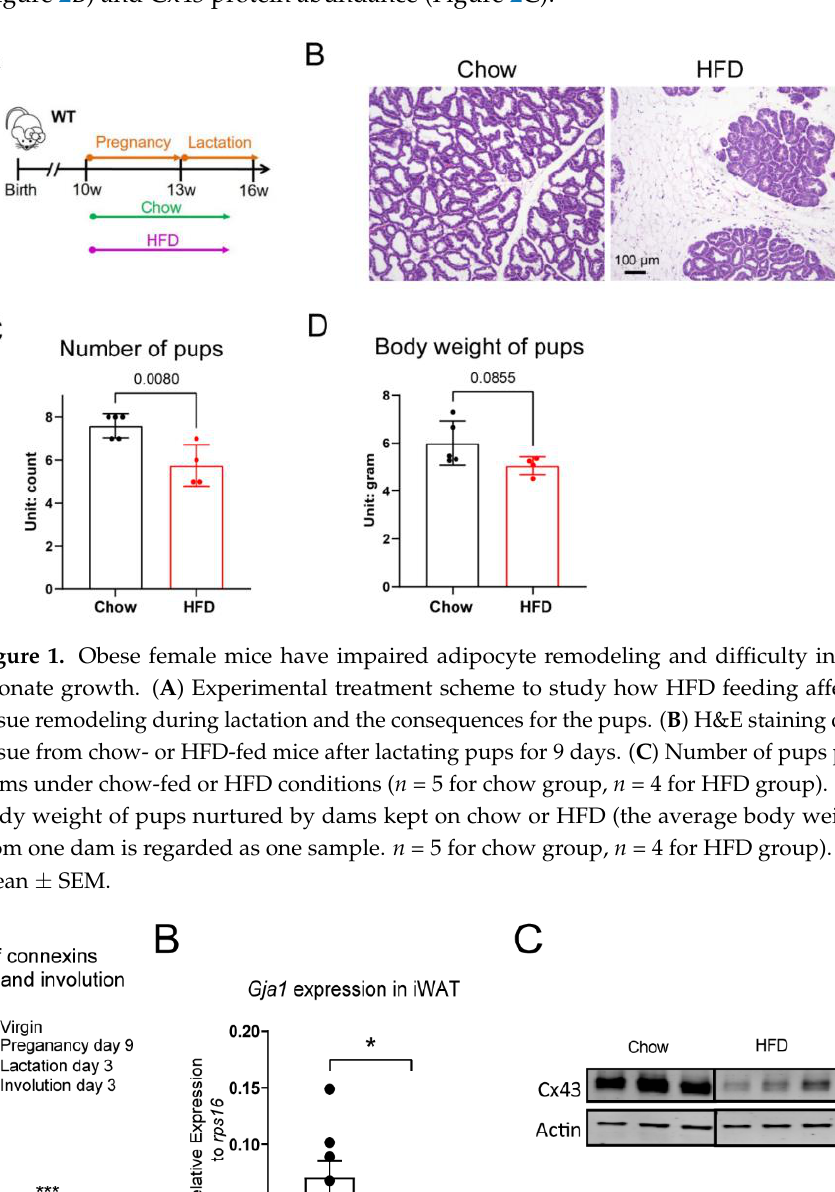
from mice kept on a HFD for 12 weeks showed a significant reduction in Gja1 expression (Figure 2B) and Cx43 protein abundance (Figure 2C). Figure 1. Obese female mice have impaired adipocyte remodeling and difficulty in supporting ne- onate growth. ( A ) Experimental treatment scheme to study how HFD feeding affects adipose tissue remodeling during lactation and the consequences for the pups. (B) H&E staining of mammary tis- sue from chow- or HFD-fed mice after lactating pups for 9 days. ( C ) Number of pups produced by dams under chow-fed or HFD conditions ( n = 5 for chow group, n = 4 for HFD group). ( D ) Average body weight of pups nurtured by dams kept on chow or HFD (the average body weight of pups from one dam is regarded as one sample. n = 5 for chow group, n = 4 for HFD group). All data are mean ± SEM.